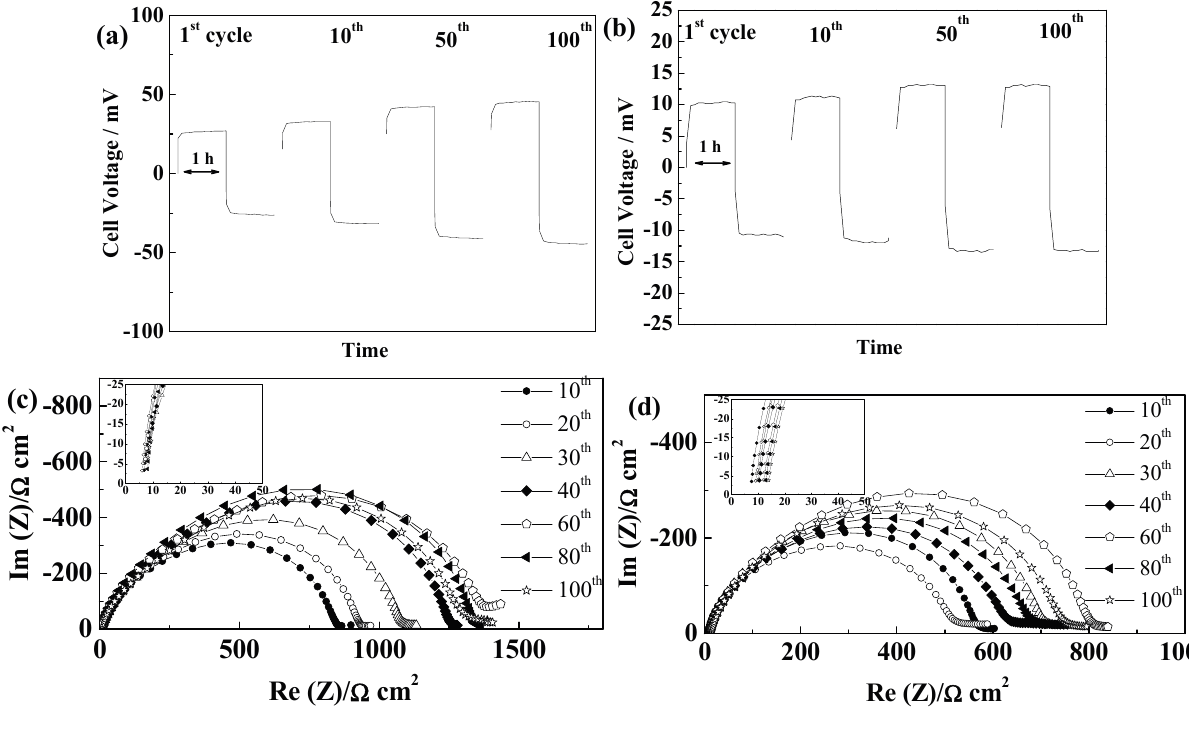
FSI cell; ( b ) Voltage profile of a PYR FSI cell; 14 12O1 FSI cell; and ( d ) Evolution of 14 FSI 12O1